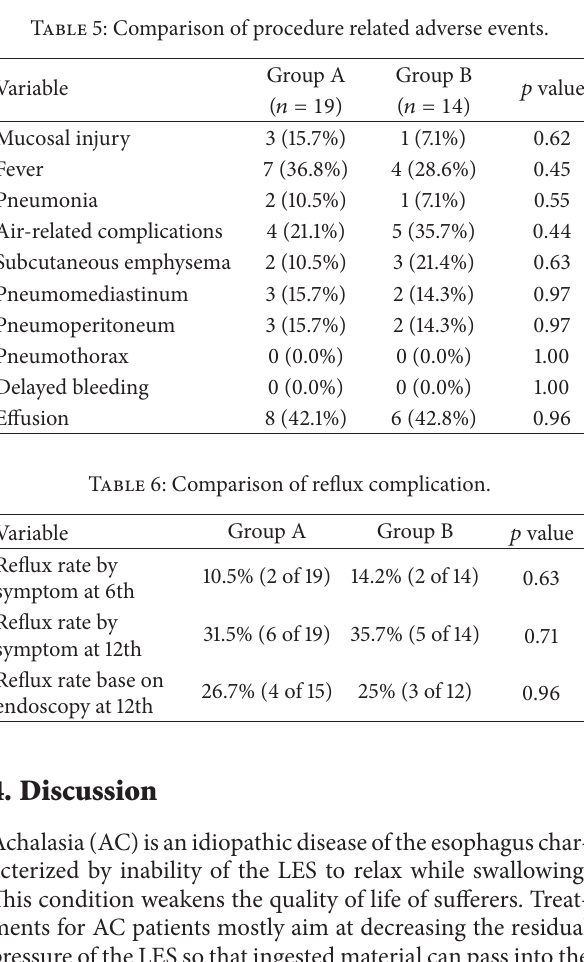
Table 5: Comparison of procedure related adverse events.